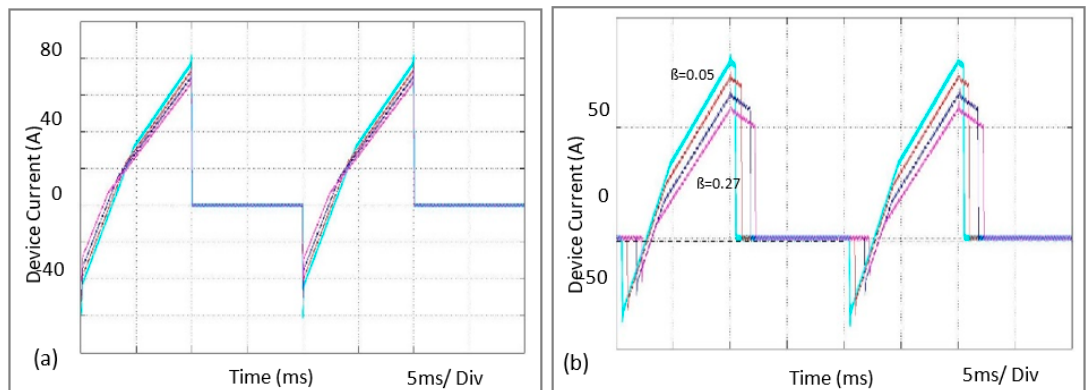
Figure 14. Experimental results of device current waveform of blended SPS-ESPS controlled DAB-IBDC converter. ( a )Primary bridge switching current; ( b ) Secondary bridge switching current.